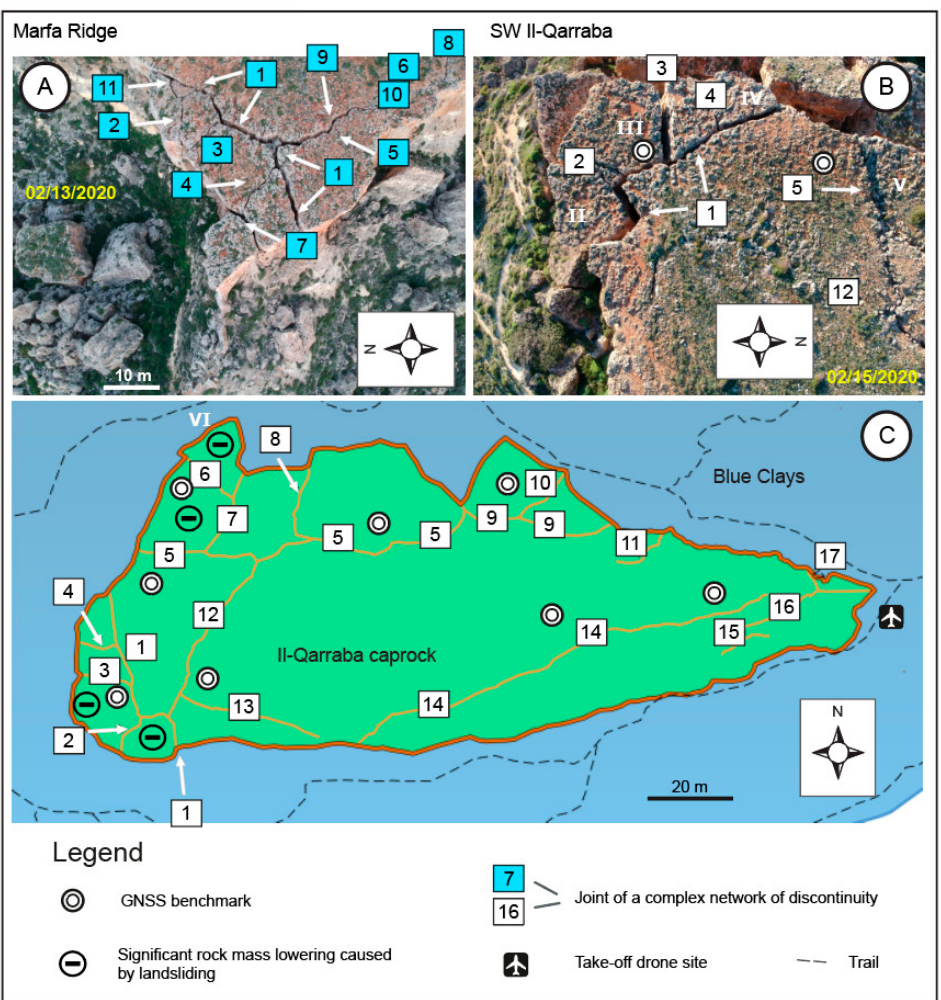
Figure 11. ( A ) Oblique view of complex network of discontinuities located in the western part of Marfa Ridge; ( B ) Spot on the western part of Il-Qarraba caprock where Rock mass # II, Rock mass # III, and Rock mass # IV are partially isolated by persistent joints; and ( C ) UAV-DP derived map of complex network of discontinuities.